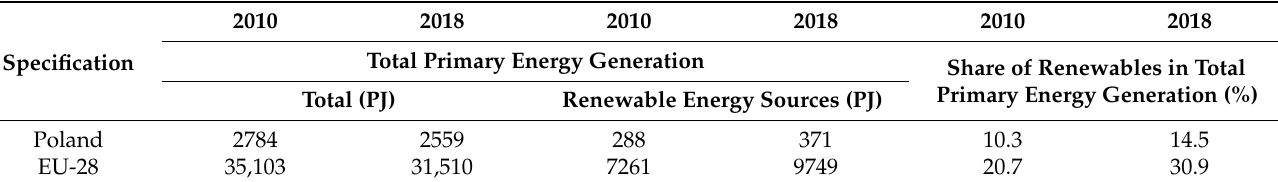
Table 1. Total primary energy generation in EU-28 and in Poland [31].